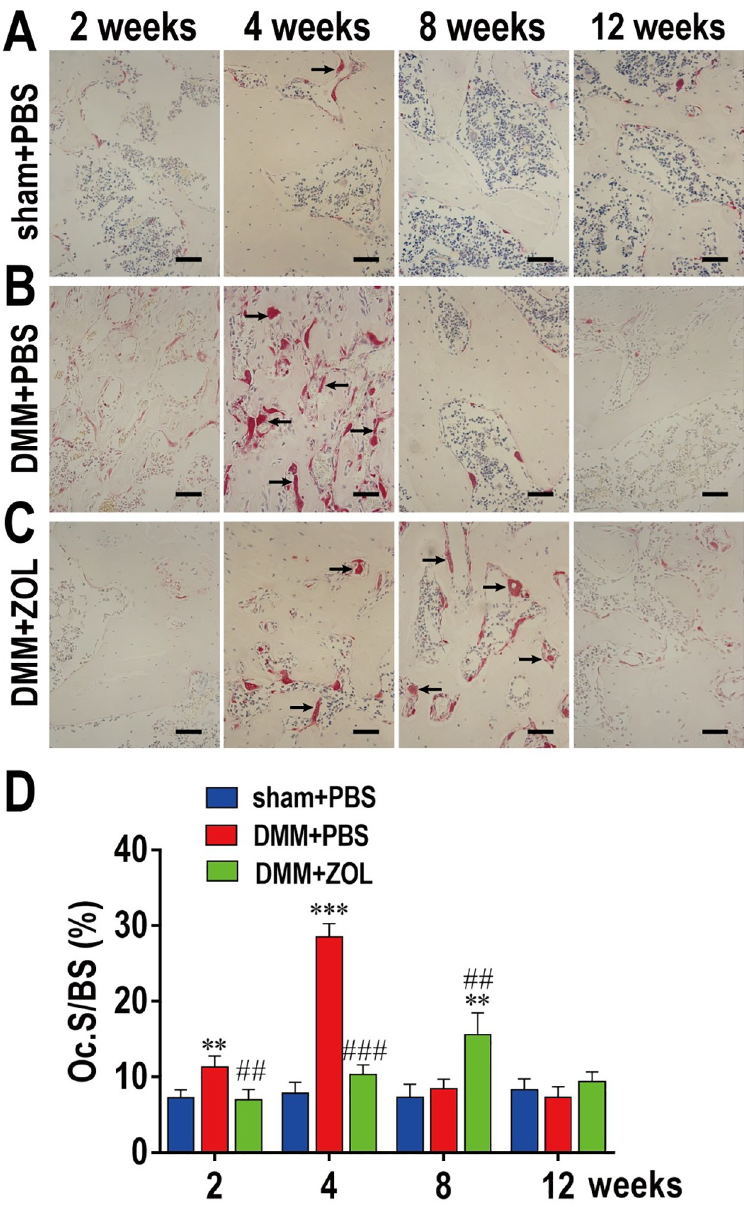
Fig 5. ZOL inhibits osteoclast formation in DMM-induced OA rats. Analysis of osteoclast formation in subchondral bone stained with (A, B and C) TRAP in coronal sections of tibia at various time-points. Scale bar, 100 μ m. Quantitative analysis of (D) Oc.S/BS at various time-points (n = 6 per group/time point). �� P < 0.01 and ��� P < 0.001, compared with sham+PBS group; ## P < 0.01 and ### P < 0.001, compared with DMM+PBS group.